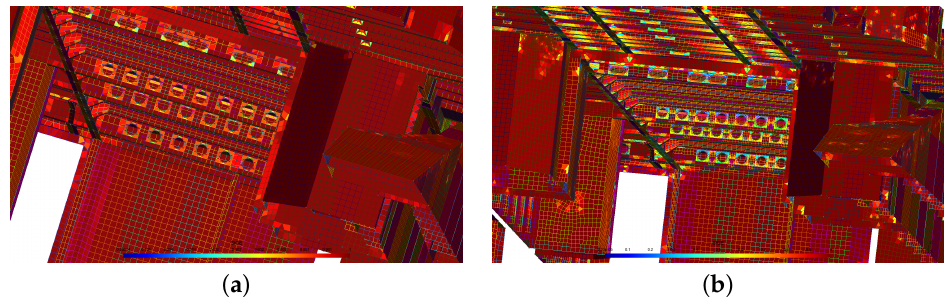
Figure 6. A comparison of the meshing algorithm on an example of a superstructure of a large yacht (geometry G 3 ). The details of the web surfaces are compared using the SIGE indicator. In ( a ), we have the mesh generated by pyREMAKmsh and in ( b ) the fully recombined